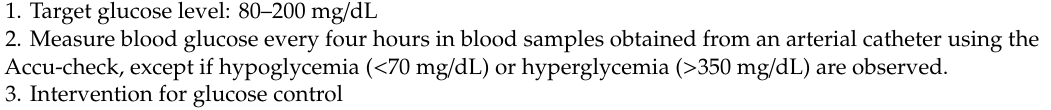
Table 1. Glucose control